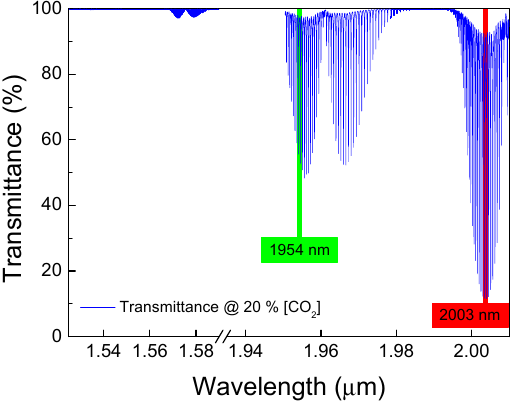
Figure 1 . Transmittance for 20% CO 2 concentration and total pressure of 1 atm in a 74 cm optical path.